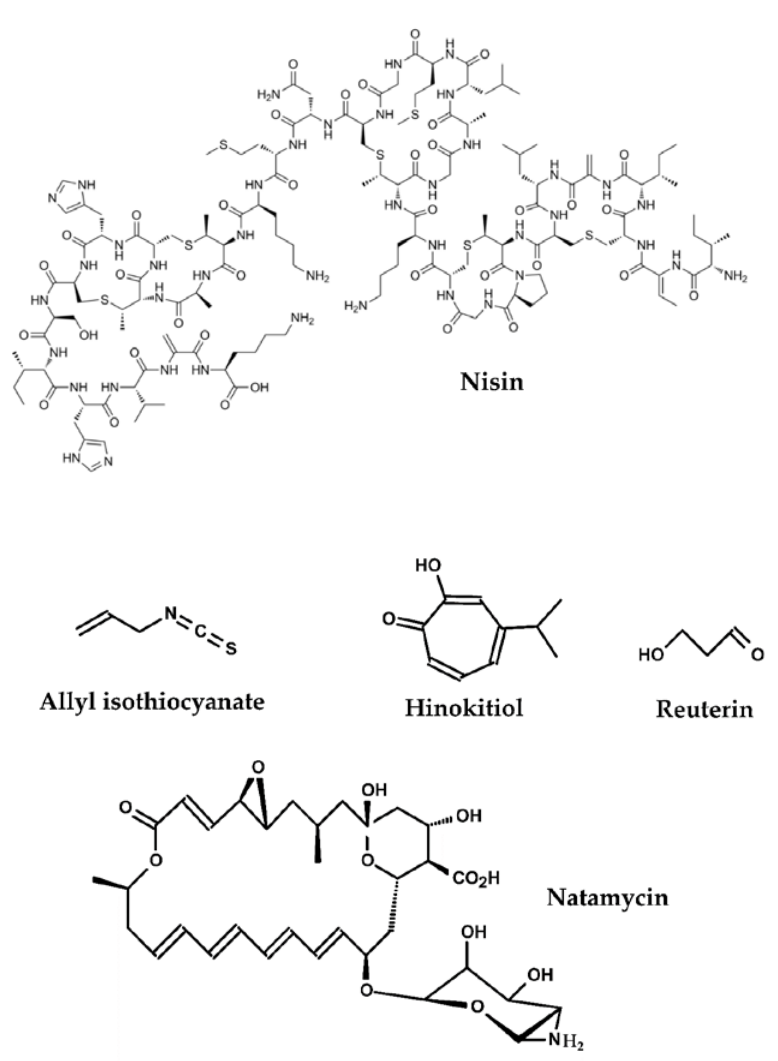
Figure 8. Natural antioxidants used in edible films/coatings preparation.